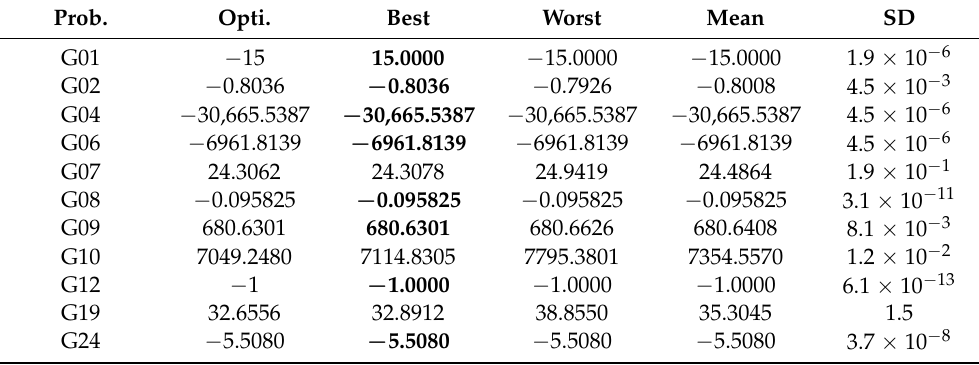
Table 5. Results obtained by the BHGA algorithm for 11 benchmark functions over 30